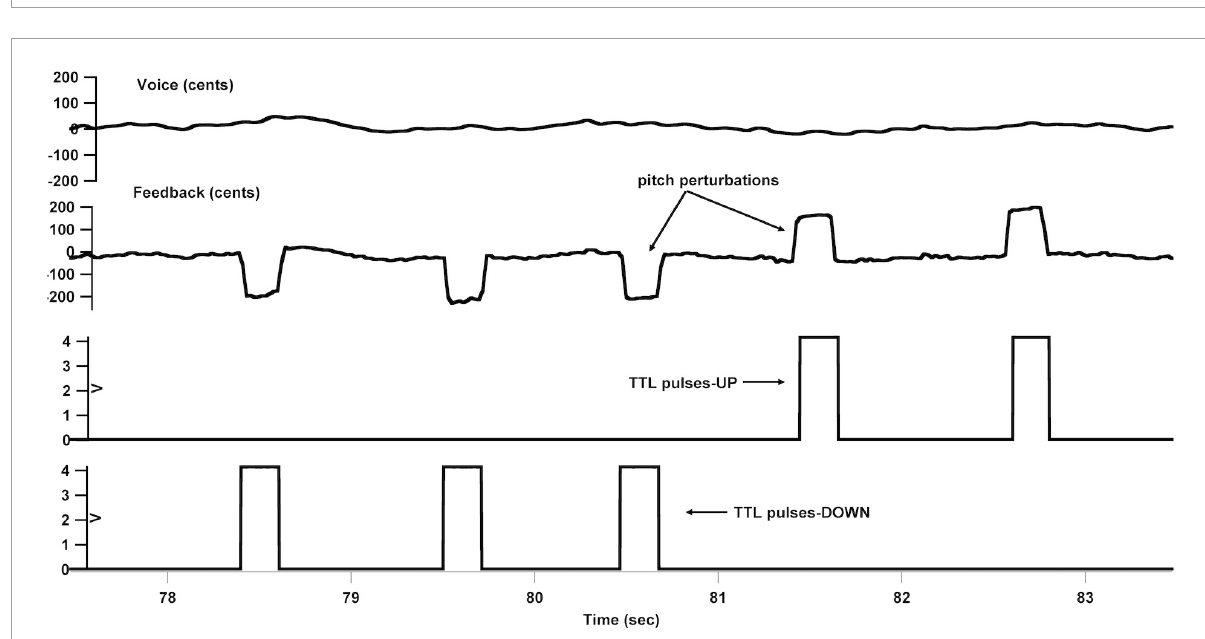
FIGURE2 Overview of the frequency-altered feedback (FAF) paradigm. From top to bottom: voice f o contour in cents, auditory feedback containing pitch perturbations in cents, and transistor-transistor logic (TTL) control pulses that signaled the onset of upward and downward pitch perturbations.